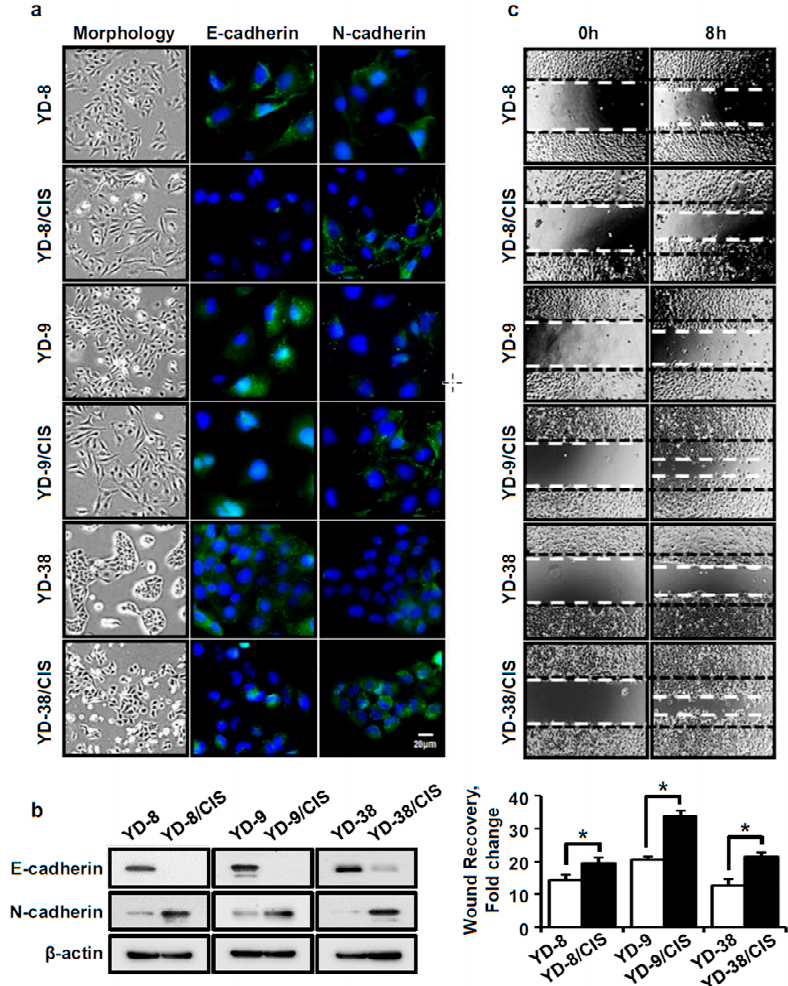
Figure 4. EMT-related markers in parental and cisplatin-resistant OSCC cell lines. ( a ) The morphological changes of cells were photographed using an Olympus CKX53 inverted microscope ( × 40). The expression levels of E-cadherin and N-cadherin (green signal) were determined by immunofluorescence assay. Blue signal corresponds to DAPI stained nuclei. Scale bar, 20 µ m. ( b ) Western blotting confirmed the expression levels of E-cadherin and N-cadherin proteins. Cell mobility and N-cadherin expression increased in cisplatin-resistant cells compared to parental cells. ( c ) Top, cell migration was analyzed by a wound healing assay ( × 40). Bottom, data represent the quantitative results for the top panel (mean ± SD; n = 3). * p < 0.01 versus parental